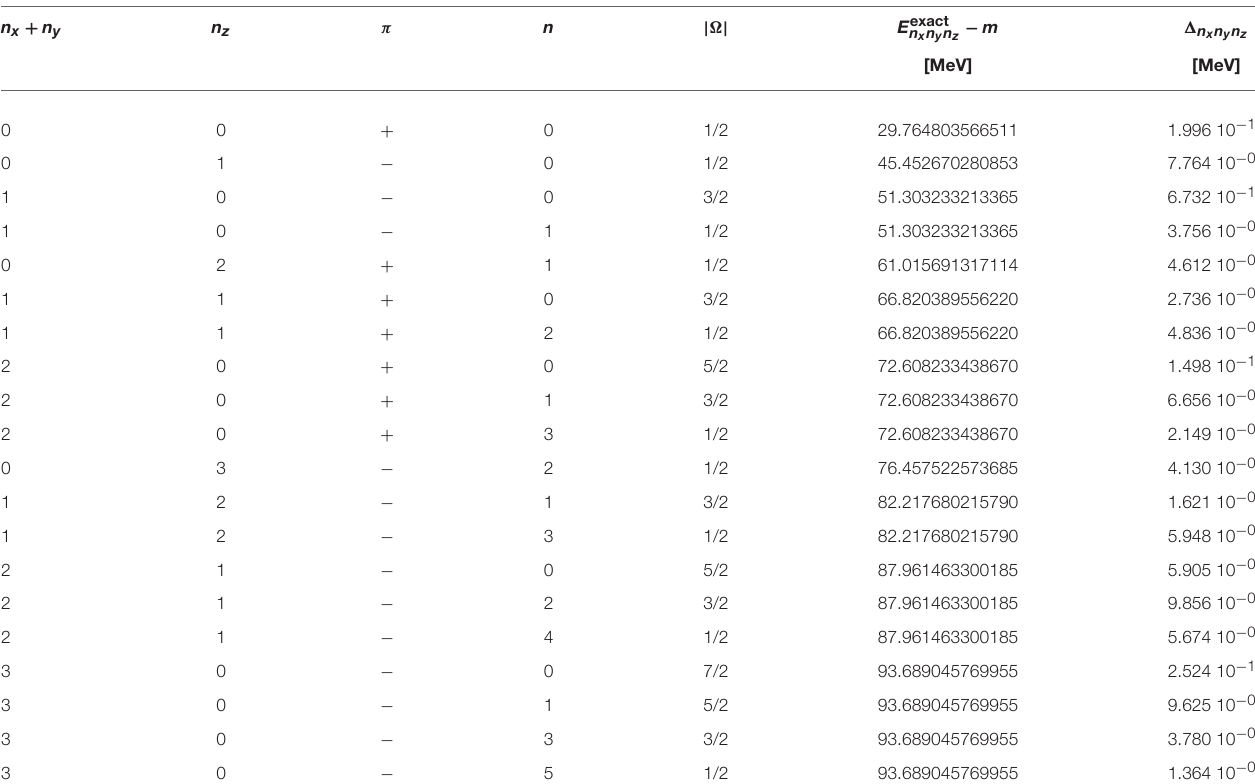
0.1, - h ω 20 MeV, and m 938 MeV/ c 2 and absolute deviation (88) of a = = = 25, and number of channels N c = =